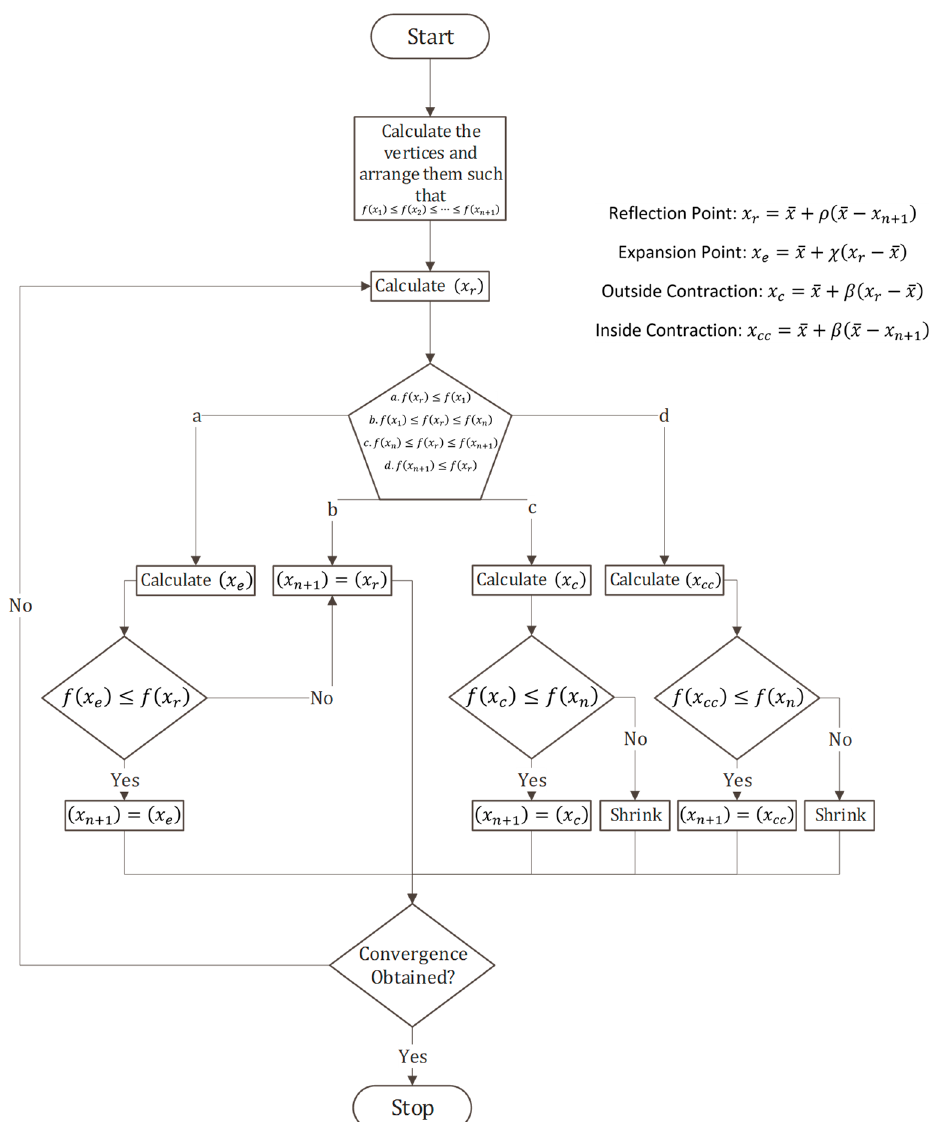
Figure 1. Flowchart representation of the Nelder–Mead optimization algorithm (Simplex method) [30].